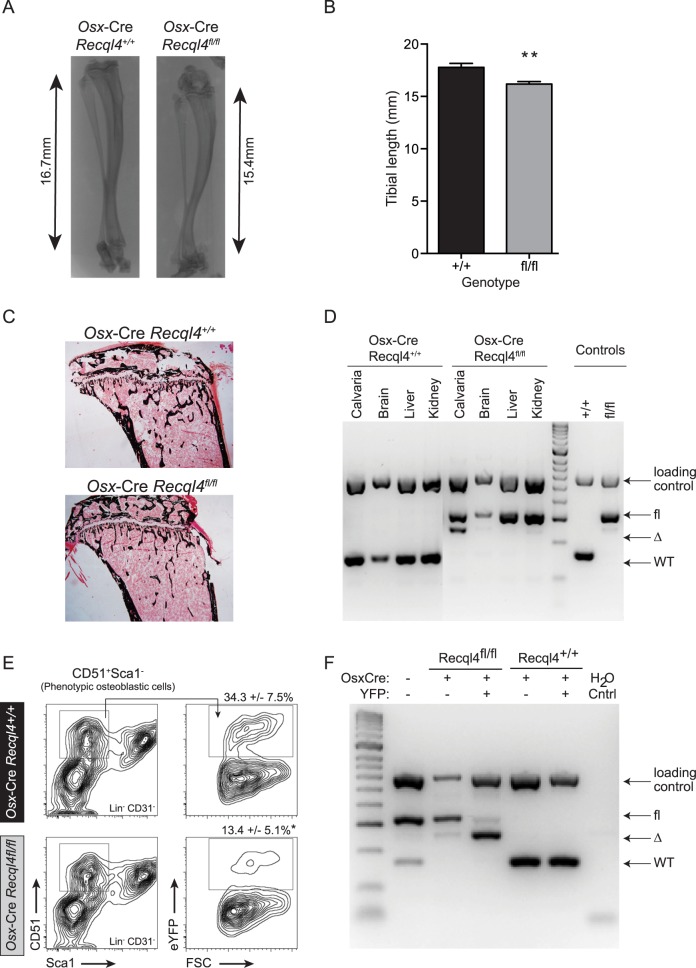

Osx-Cre Recql4
fl/fl mice have reduced bone length.(A) X-ray of tibia from male Osx-Cre Recql4
+/+ and Recql4
fl/fl mice. (B) Measurement of tibial length from Osx-Cre Recql4
+/+ and Recql4
fl/fl mice. n≥ 9 for both genotypes. Data presented as mean±SEM. **P<0.01 compared with Recql4
+/+, t-test. (C) Representative photo of Von Kossa staining of 9 week old Osx-Cre Recql4 tibiae. (D) Detection of Recql4 genomic excision in various tissues from Osx-Cre mice. (E) Percentage of FACS-sorted osteoblastic cells (Lin- CD31- CD51+ Sca1-) from Osx-Cre Recql4 mice. Data presented as mean±SEM. *P<0.05 compared with Recql4
+/+, t-test. (F) Osteoblastic cells from Osx-Cre R26YFP Recql4 mice were sorted into eYFP+ve and eYFP-ve fractions prior to genomic DNA extraction and assessment of Recql4 genomic excision.